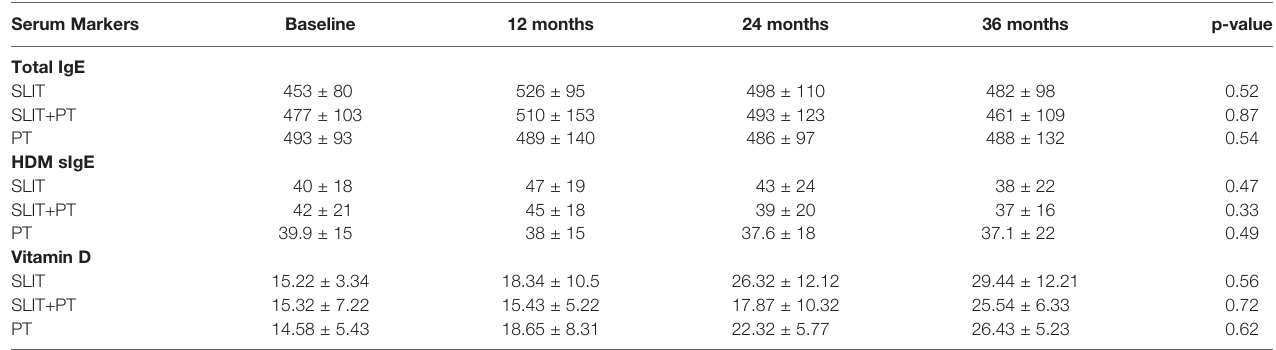
TABLE 3 | Effect of 3 years of AIT on serum markers. Serum Markers